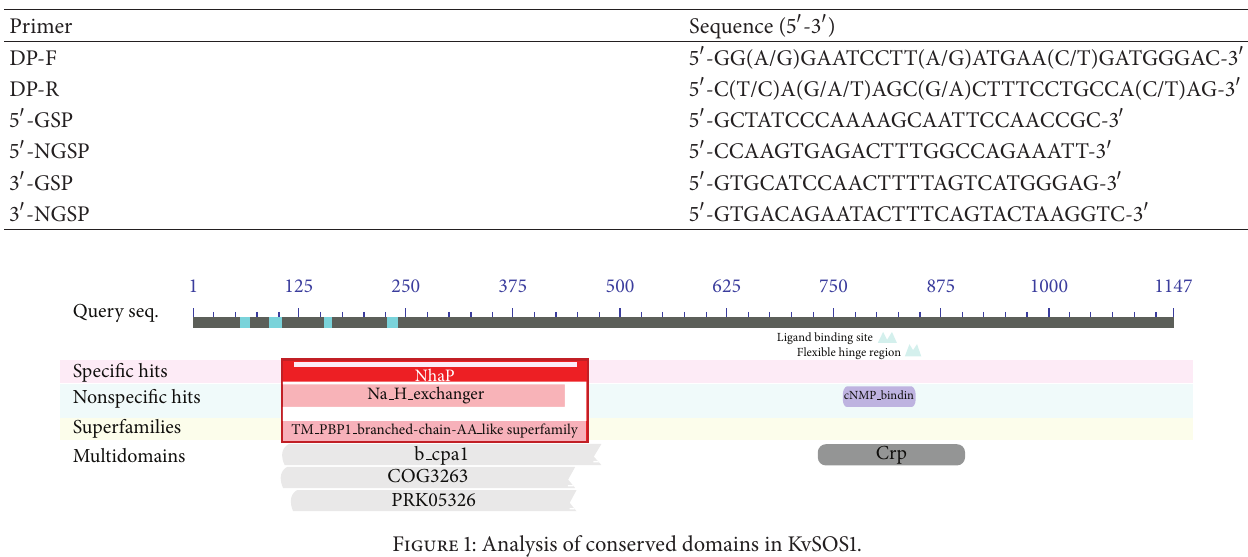
Table 1: The primers used in this study.